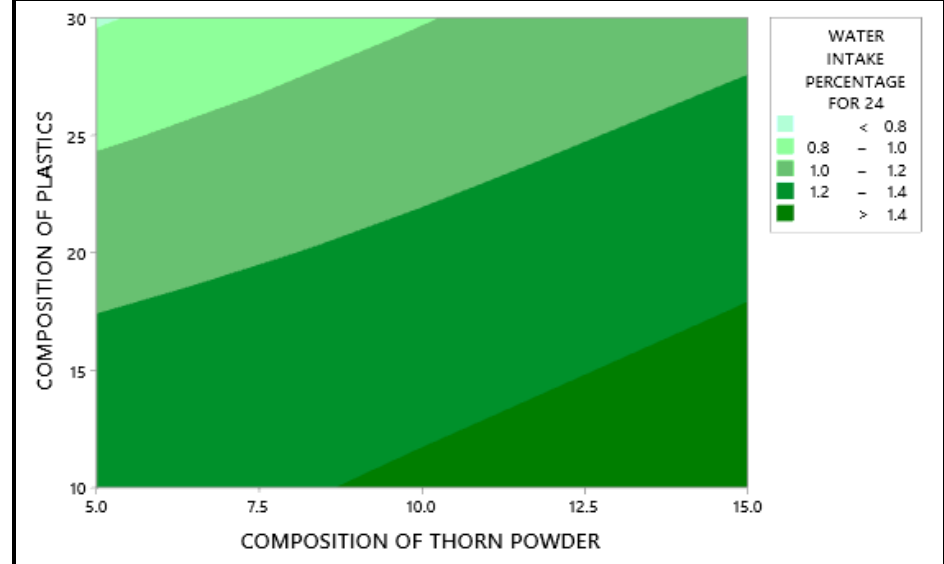
Figure 7. Water intake test result through contour graph. Table 4. Water intake results from